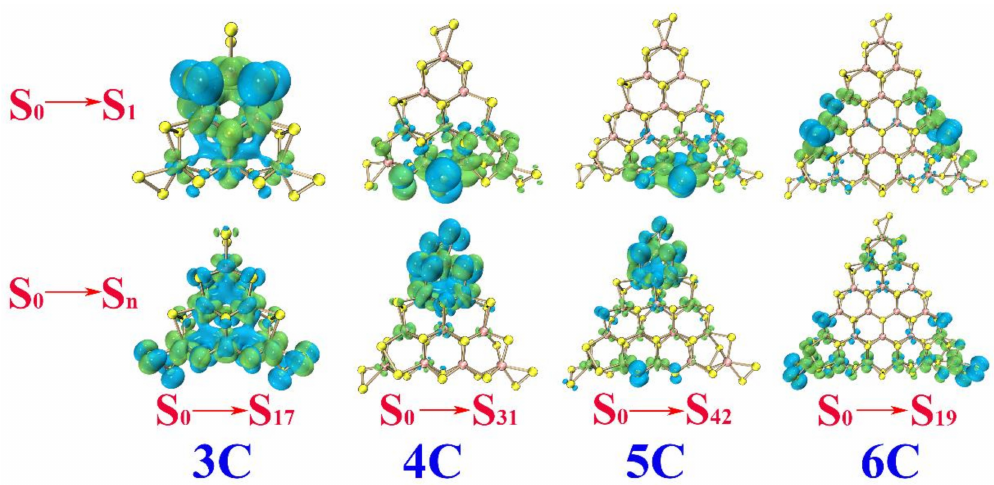
Figure 6. Electron (green) and hole (blue) distributions with isosurface 0.0006 for 3C , 4C , 5C and 6C